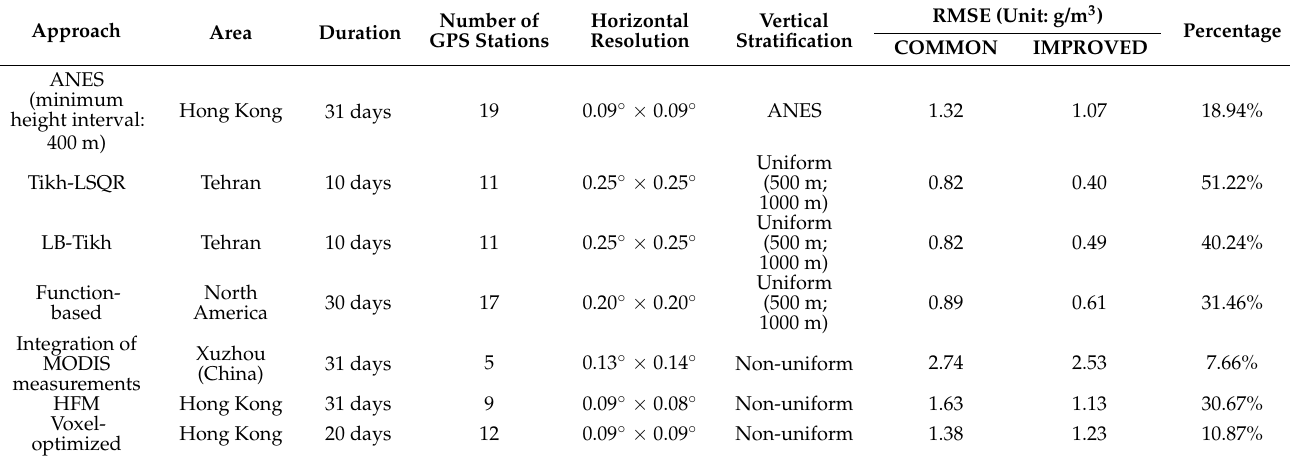
Table 3. Comparison of tomographic strategies used by developed approaches and their improvements to the accuracy of tomographic